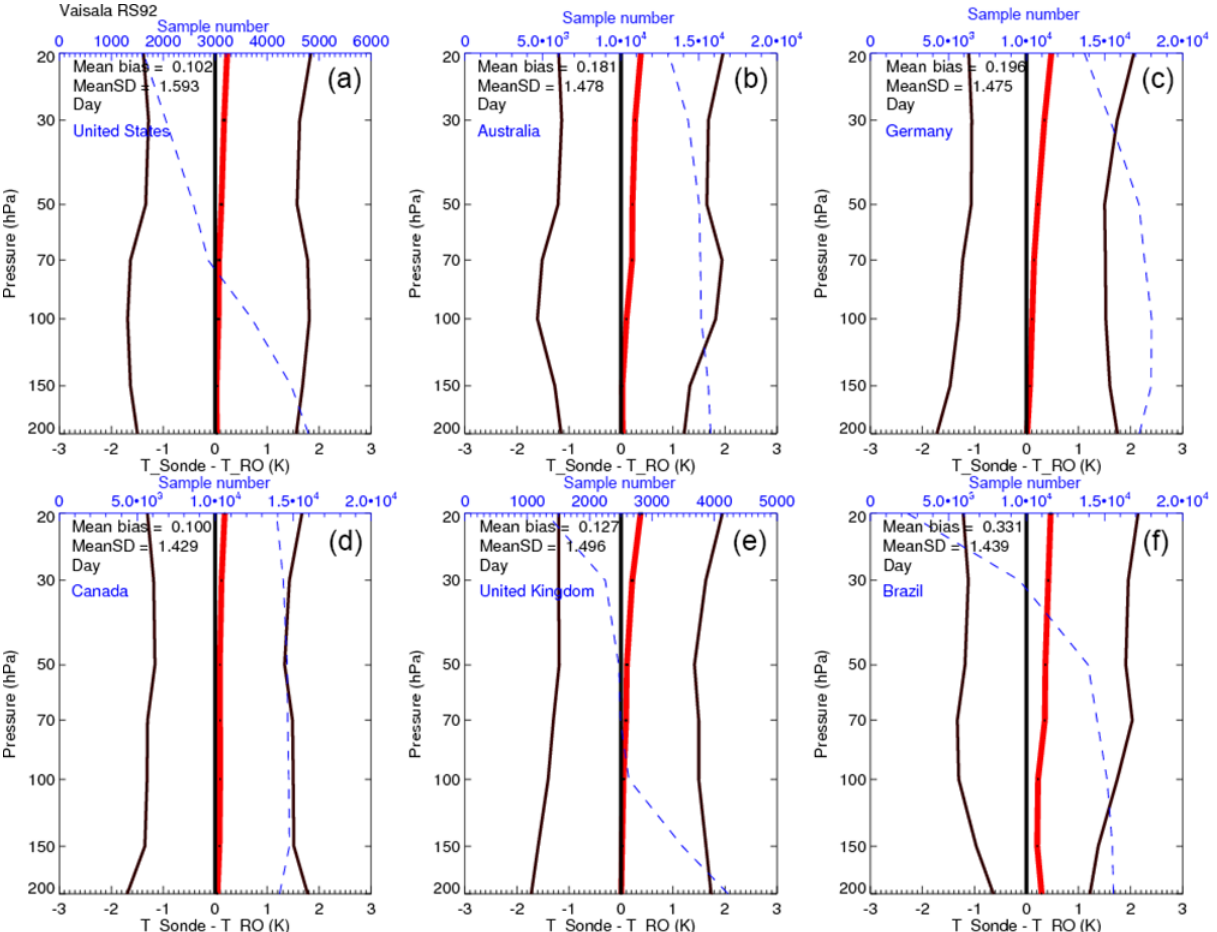
Figure 3. Comparisons of temperature between RS92 and RO for daytime over (a) United States, (b) Australia, (c) Germany, (d) Canada, (e) United Kingdom, and (f) Brazil. The red line is the mean difference; the black line is the standard deviation of the mean difference; the dotted line is the sample number. The top x axis shows the sample number. The same symbols are also used for the following plots. We also plot the standard error of the mean (black dot) superimposed on the mean. The value of the standard error of the mean is less than 0.03K depending on the sample